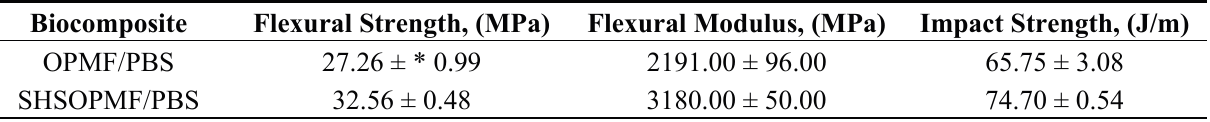
Table 2. Flexural strength, flexural modulus and impact strength of untreated OPMF/PBS and SHSOPMF/PBS biocomposites.